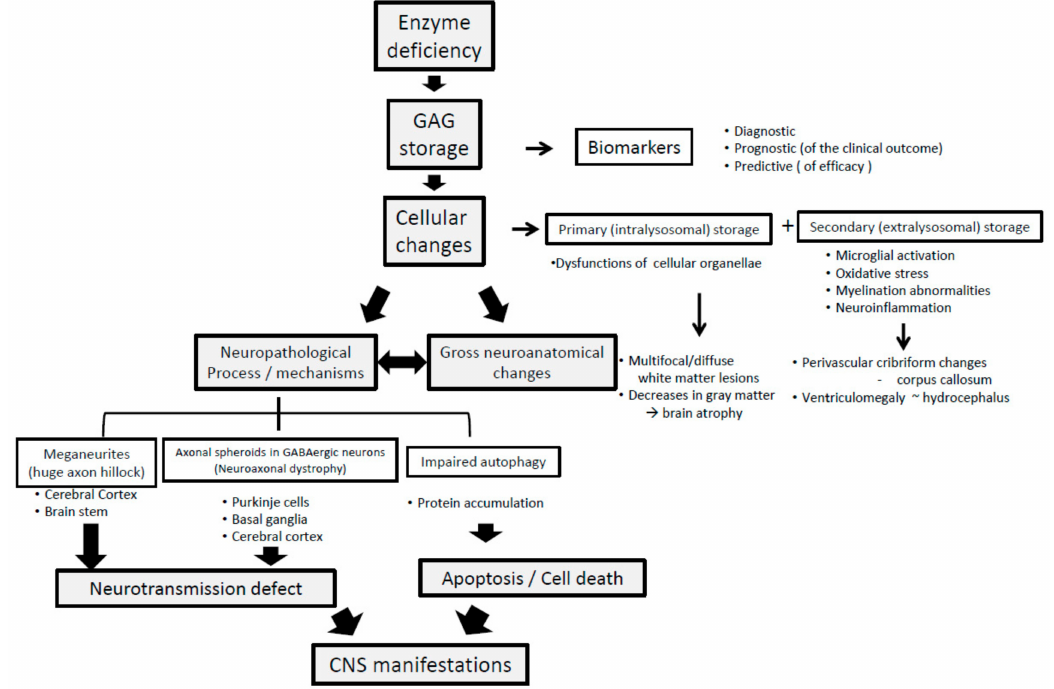
Figure 1. Neuropathological progression in neuropathic